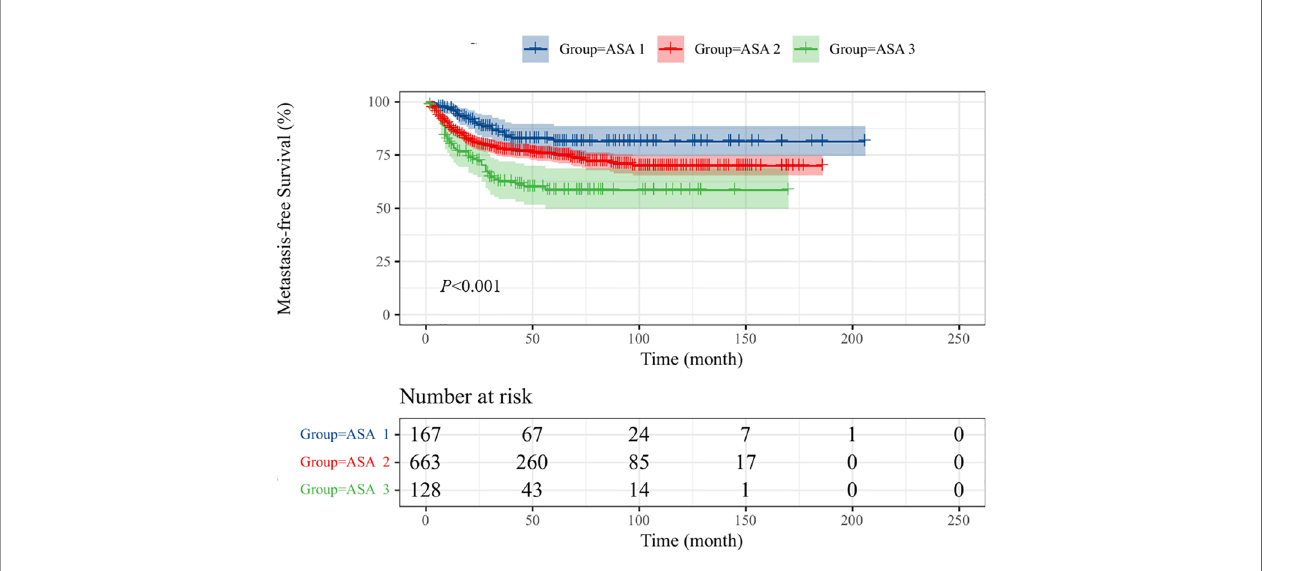
FIGURE 3 | Kaplan-Meier curves for MFS strati fi ed according to ASA